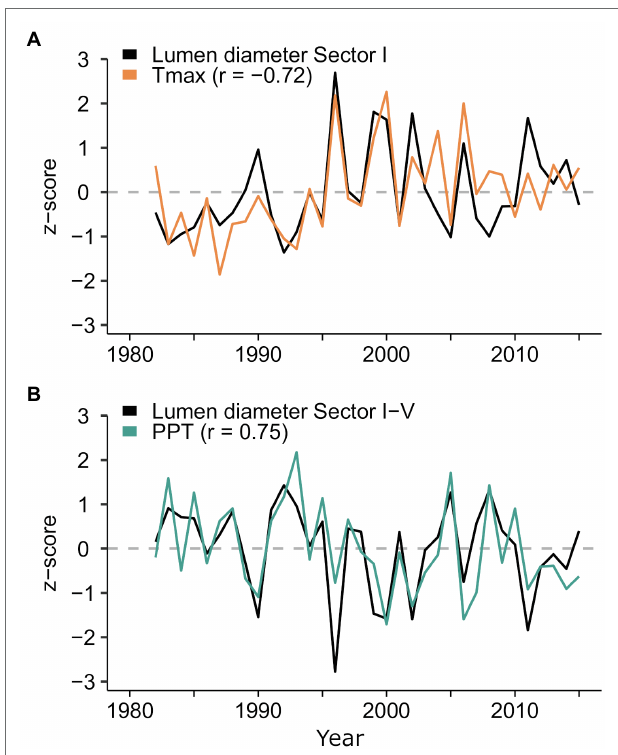
FIGURE 6 | Normalized time series of radial lumen diameter chronologies for sector I and for the average between sectors I-V plotted against (A) temperature and (B) precipitation. Climate data are the average daily Tmax from September 25 th to January 23 rd , and the sum of daily precipitation from previous October 27 th to current February 13 th . The sector I chronology of lumen diameter is shown with opposite sign for easier comparison with the temperature time